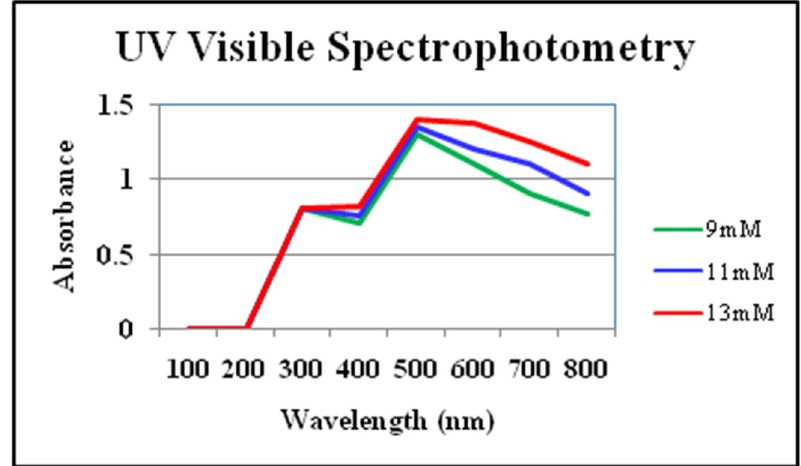
Figure 2. UV absorbance spectrum for FeNPs synthesized by Phoenix dactylifera leaves extract.